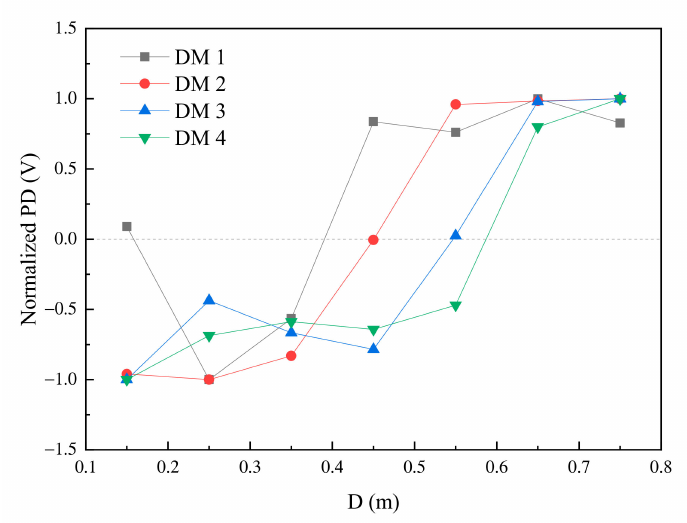
Figure 9. Distributions of PD for L2 on the different dam models. The D refers to the distance to dam crest along the downstream slope. The black square symbols, the red circle symbols, the blue triangle symbols, and the green inverted triangle symbols represent the PD for DM 1, DM 2, DM 3, and DM 4,